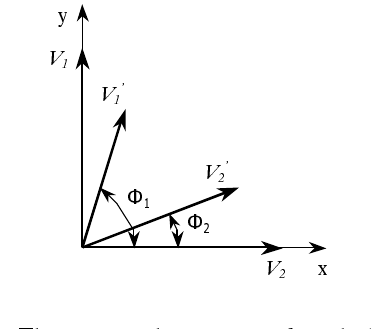
Fig 2. The vectors scheme, meant for calculation of the speed of movement of the automobiles prior to their